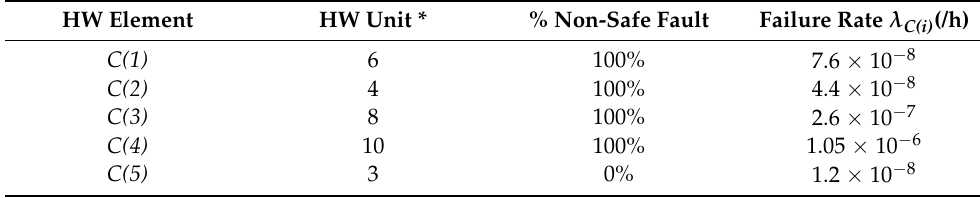
Table 2. The hardware elements and their failure